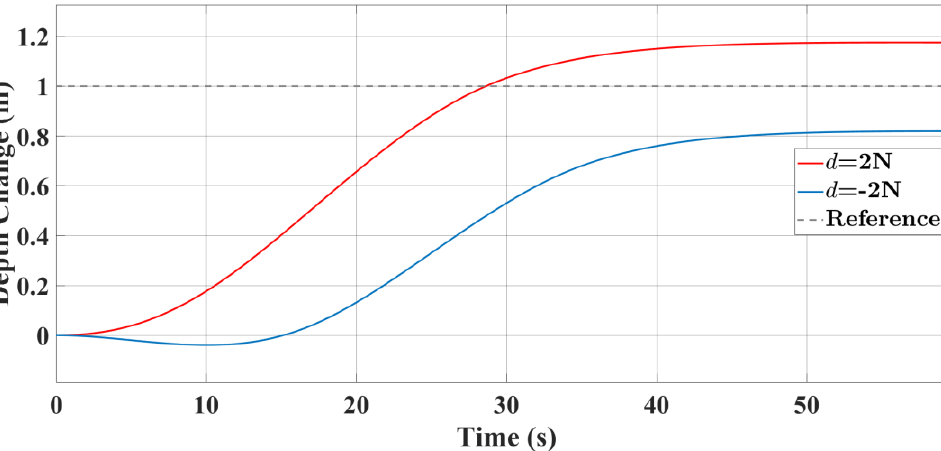
Figure 22. Hovering control responses under external disturbances.